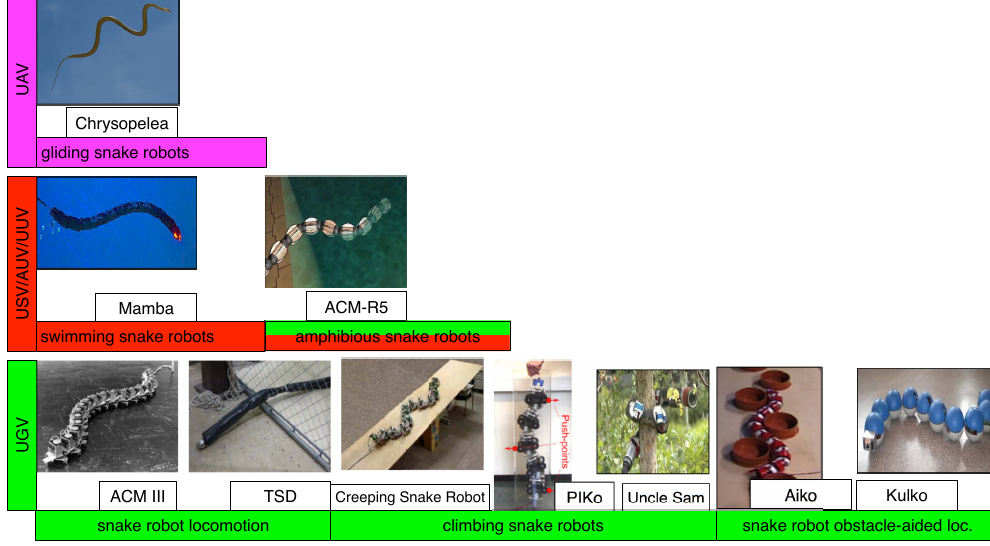
Figure 2. The variety of possible application scenarios for snake robots. AUV: autonomous underwater vehicle; TSD: toroidal skin drive snake robot; UAV: unmanned aerial vehicle; UGV: unmanned ground vehicle; USV: unmanned surface vehicle; UUV: unmanned undersea/underwater